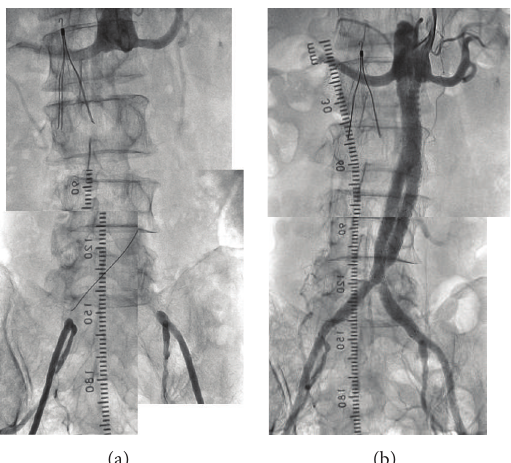
Figure 5: (a) Aortography showed that the terminal aorta was occluded from the level of the renal artery to the bilateral common iliac arteries. (b) After EVT, aortography showed that the bilateral common iliac arterial flow was restored. EVT: endovascular therapy.